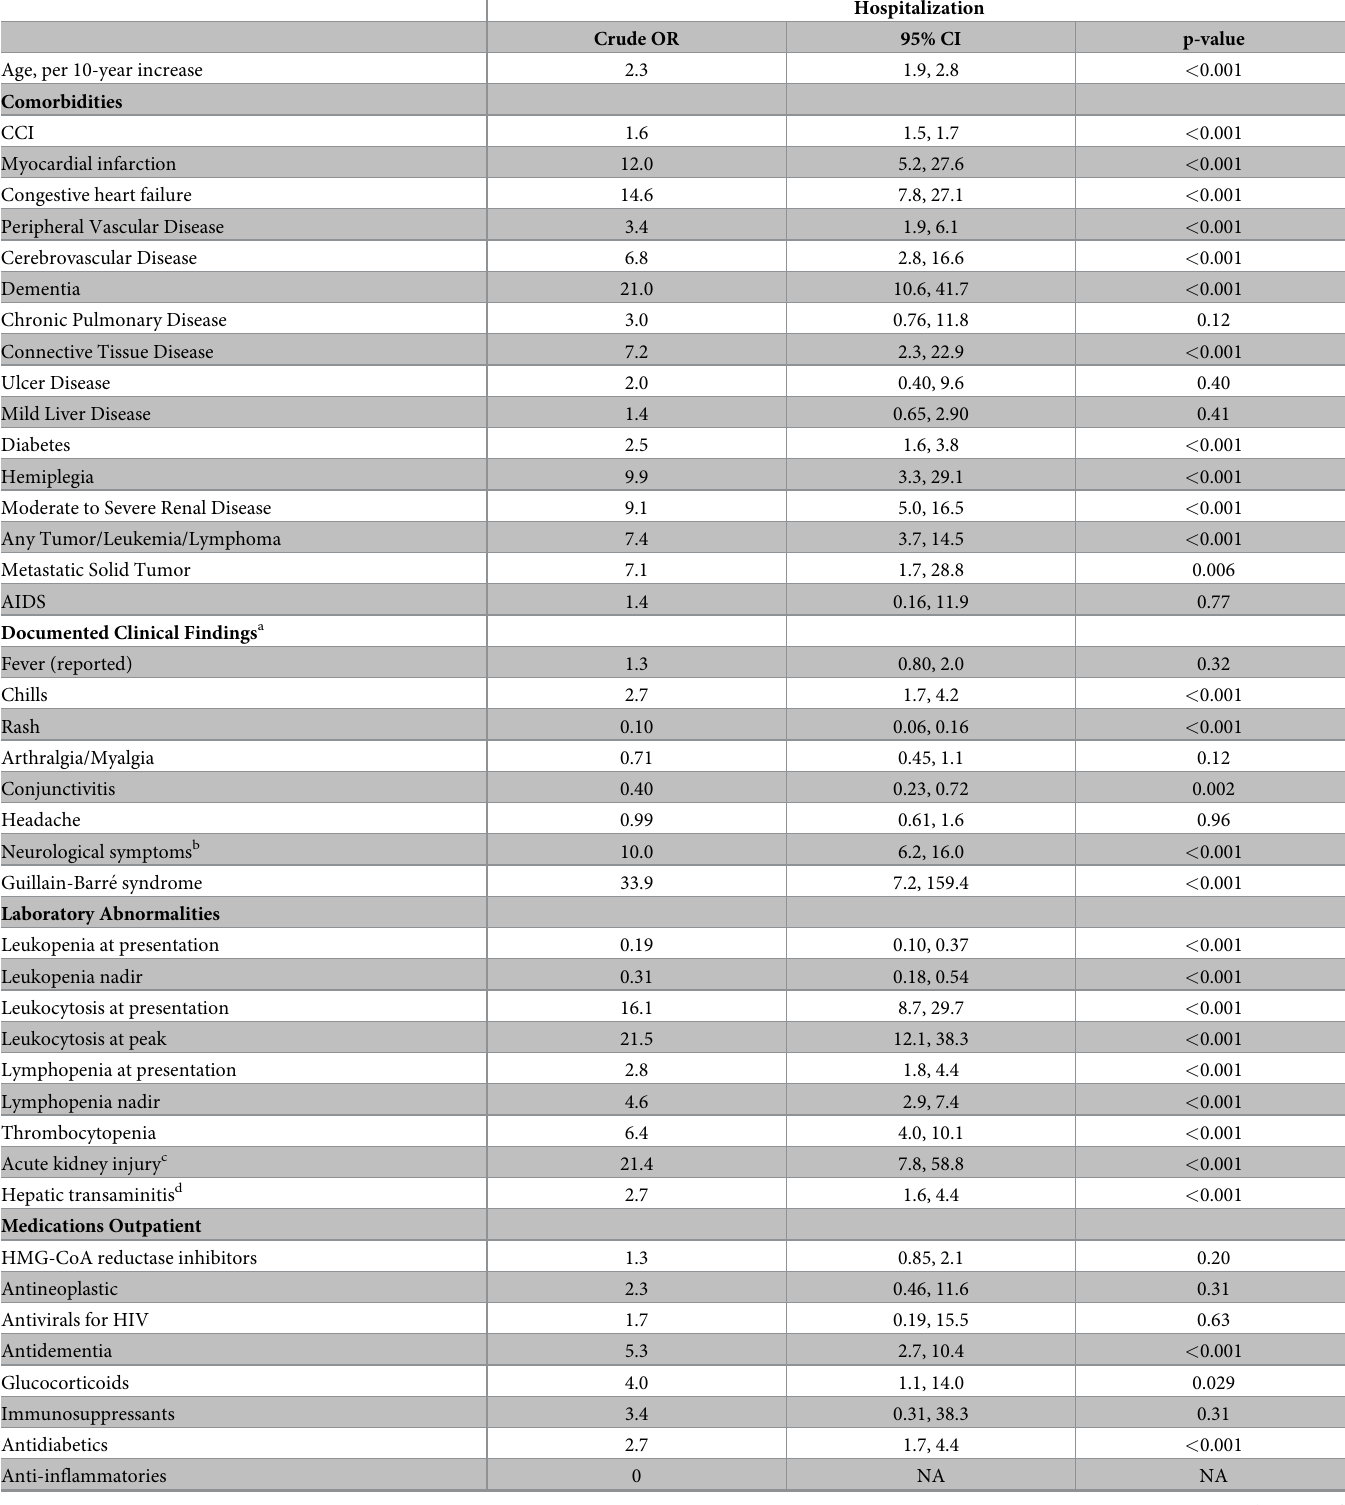
Table 3. Risk factors associated with hospitalization among patients with ZIKV